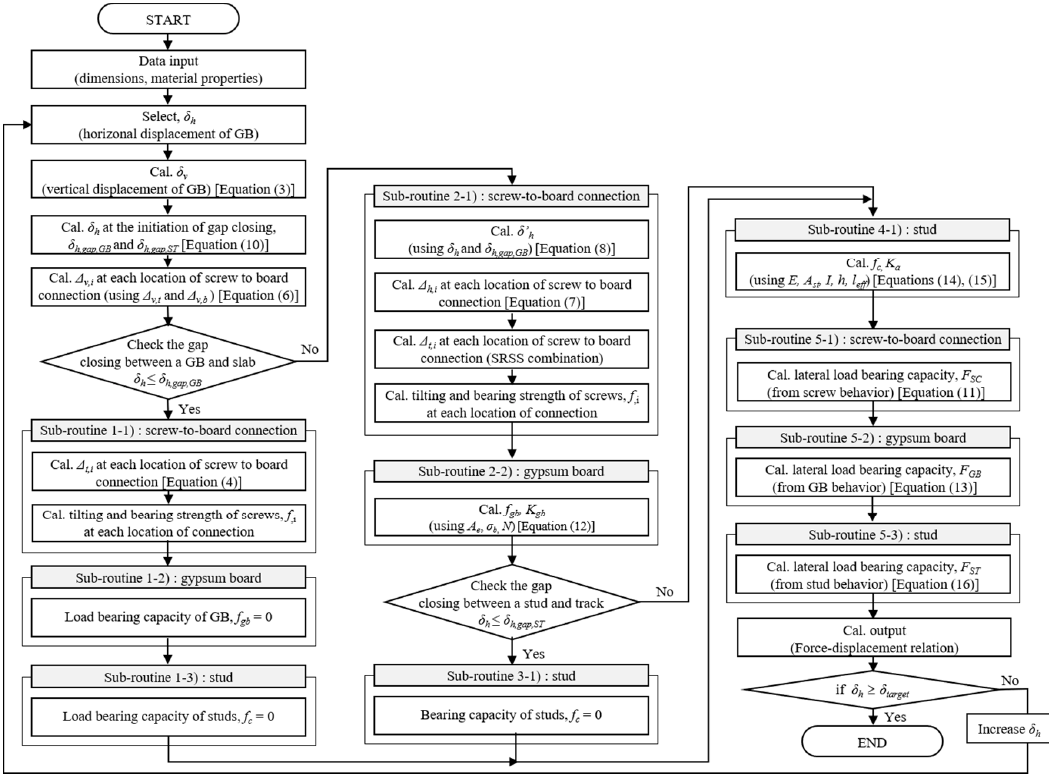
Figure 6. Flow chart for the monotonic behavior of a CFS partition wall.